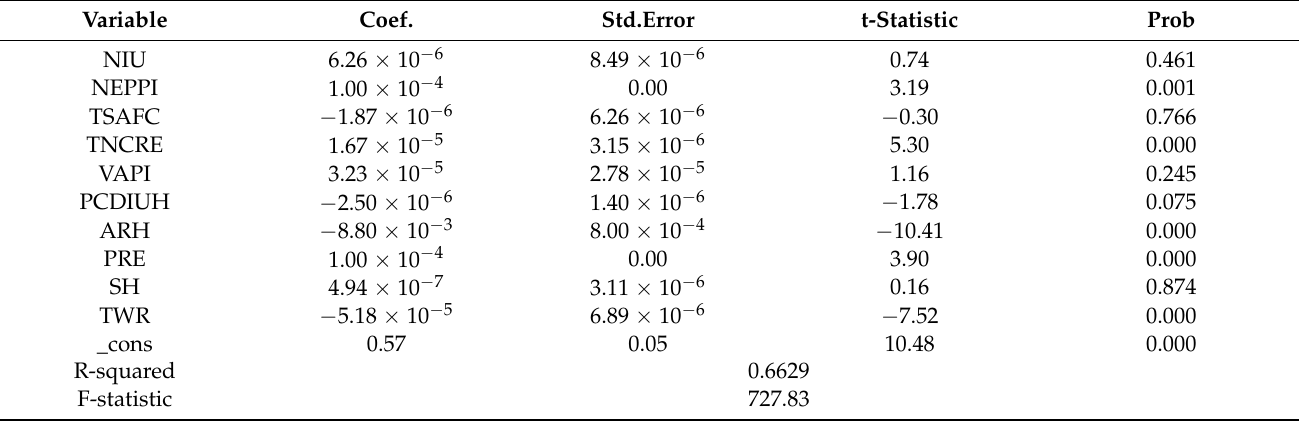
Table 9. Regression analysis with two-stage least squares